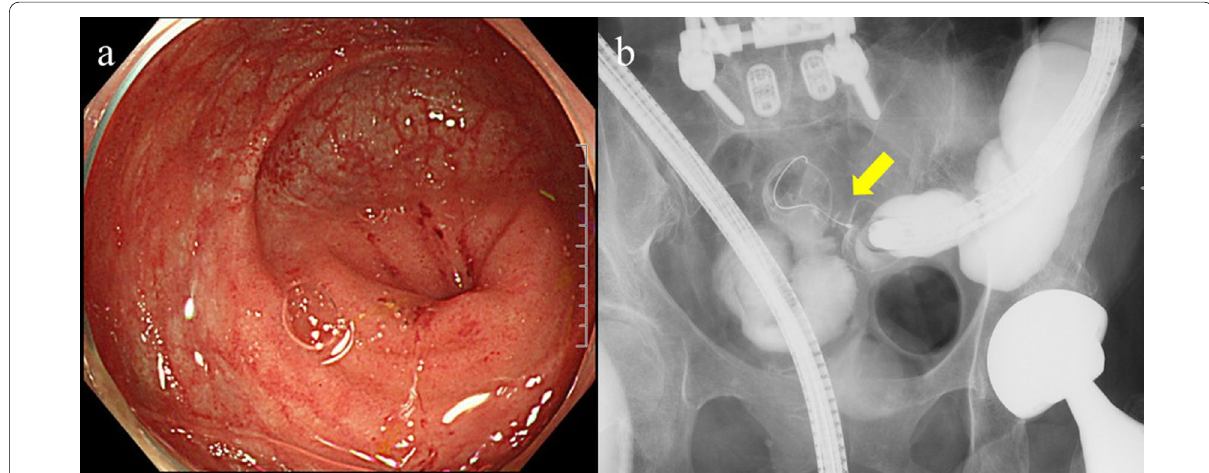
Fig. 2 Colonoscopy and contrast study findings. Colonoscopy showed circumferential stenosis of the terminal ileum and a little edematous red